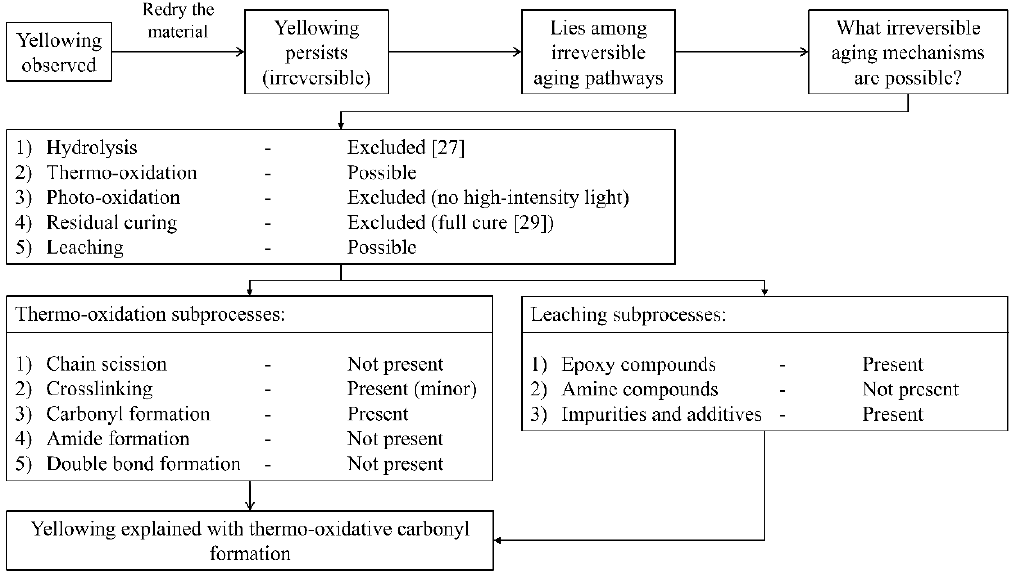
Figure 9. Schematic representation of the logic during investigation.